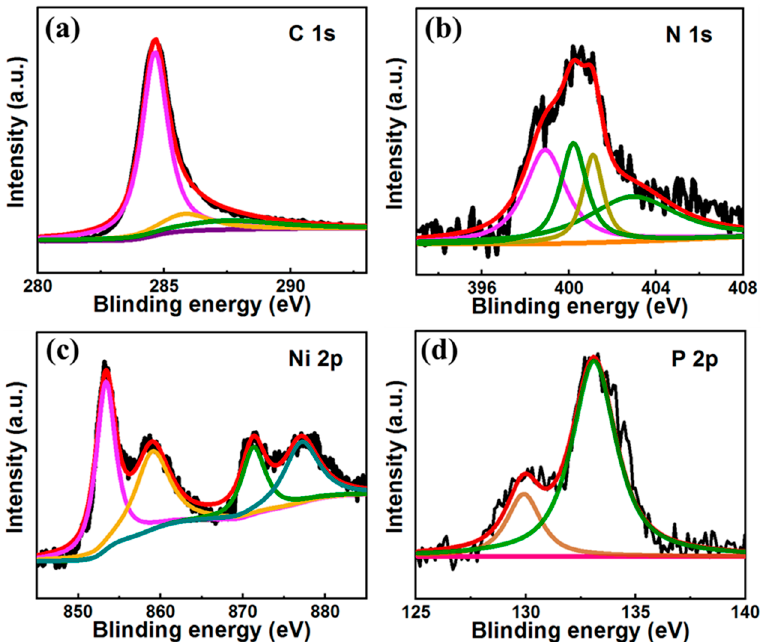
Figure 4. X-ray photoelectron spectroscopy (XPS) spectra of ( a ) C, ( b ) N, ( c ) Ni and ( d ) P.